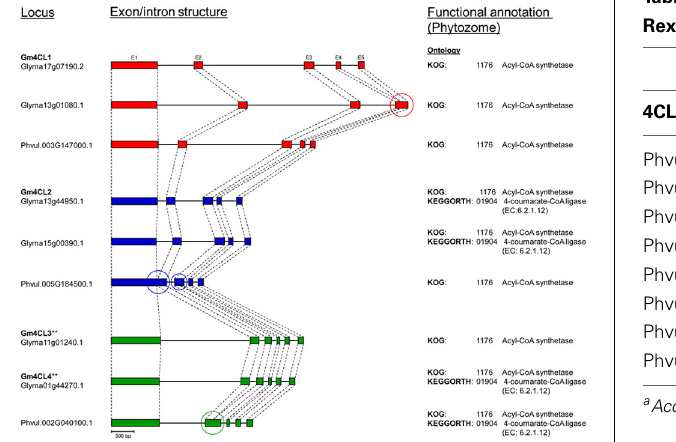
FIGURE 5 | Comparison of 4CL genes exon/intron structure between soybean (Williams 82, Phytozome) and common bean (G19833, Phytozome). Exons (E) are represented as filled boxes and introns are shown as lines between the exons. ∗∗ Exon/intron structure (exon 1 and